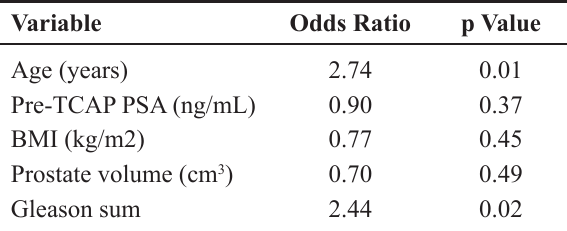
Table 6 – Logistic regression analysis for predicting dis- ease-recurrence utilizing continuous variable